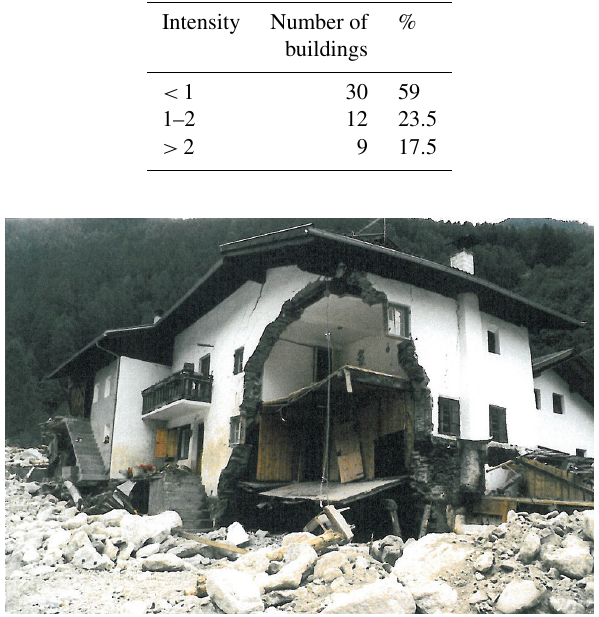
Figure 4. Example of photographic documentation following the August 1987 event (source: municipality of Martell).